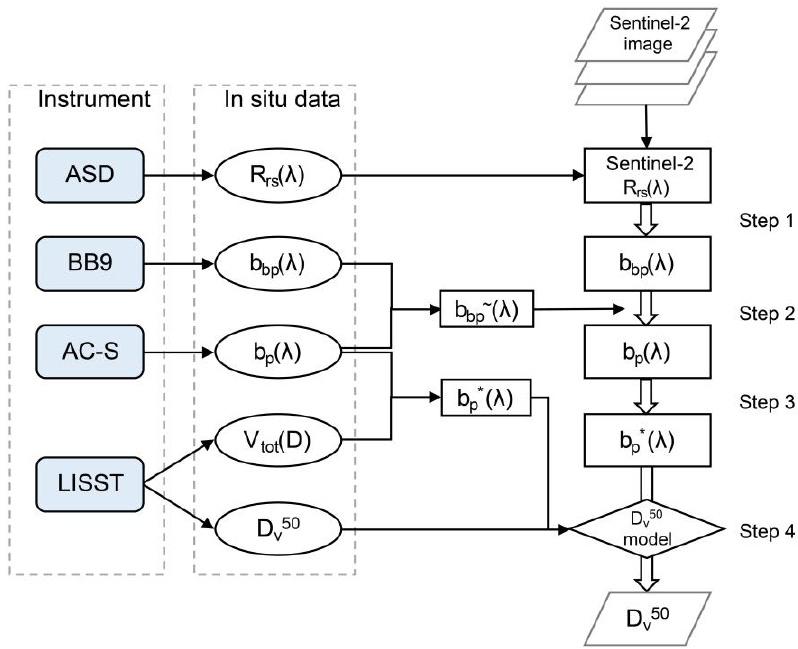
Figure 2. D v50 retrieval schematic flow chart.